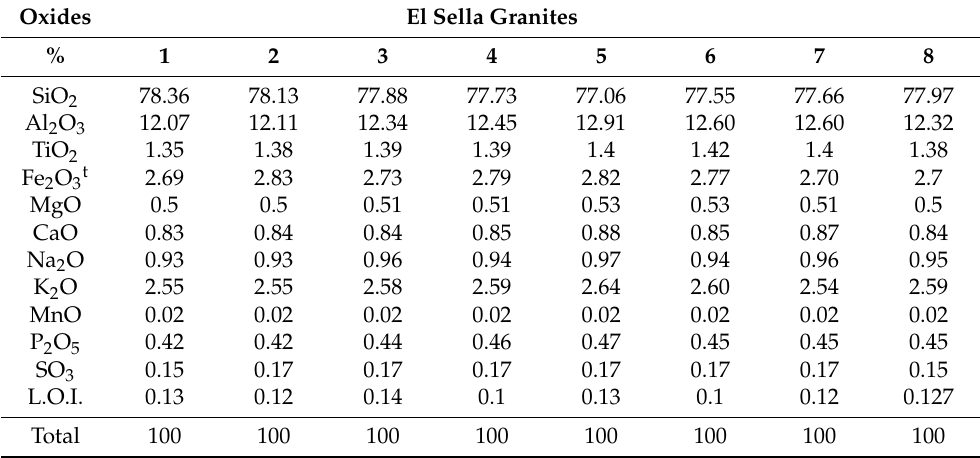
Table 1. Major oxides, trace, and rare earth elements with some of their ratios and the calculated tetrad effect of the studied altered